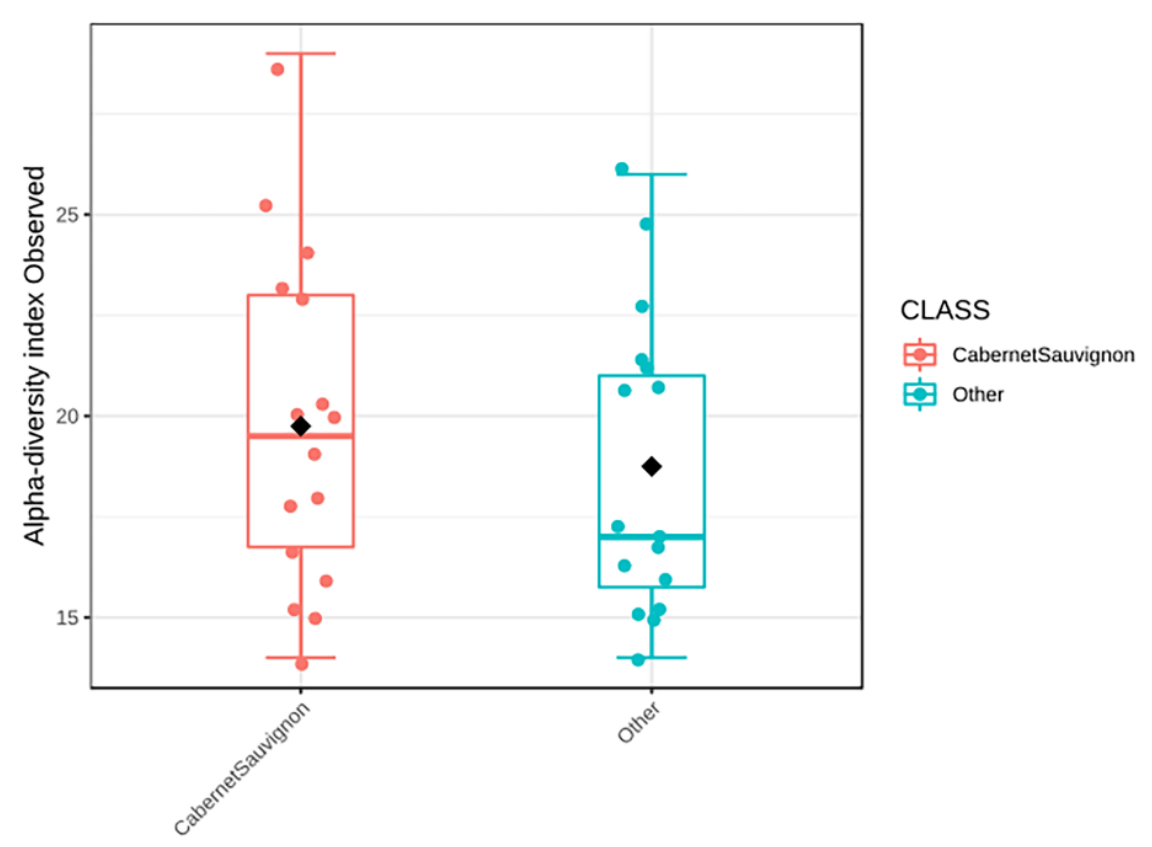
Figure A4. Comparative analysis of alpha-diversity index measured for the Cabernet Sauvignon cultivars versus the local cultivars. The colored solid line inside the box is the median value, and the black rhombus is the mean value; the colored dots are individual samples.